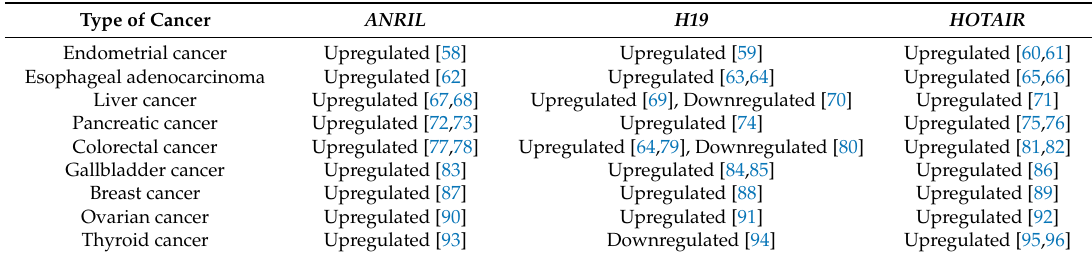
Table 1. Summary of the recent findings on antisense non-coding RNA in the INK4 locus ( ANRIL ), H19 , and HOX transcript antisense RNA (HOTAIR) in various human obesity-induced